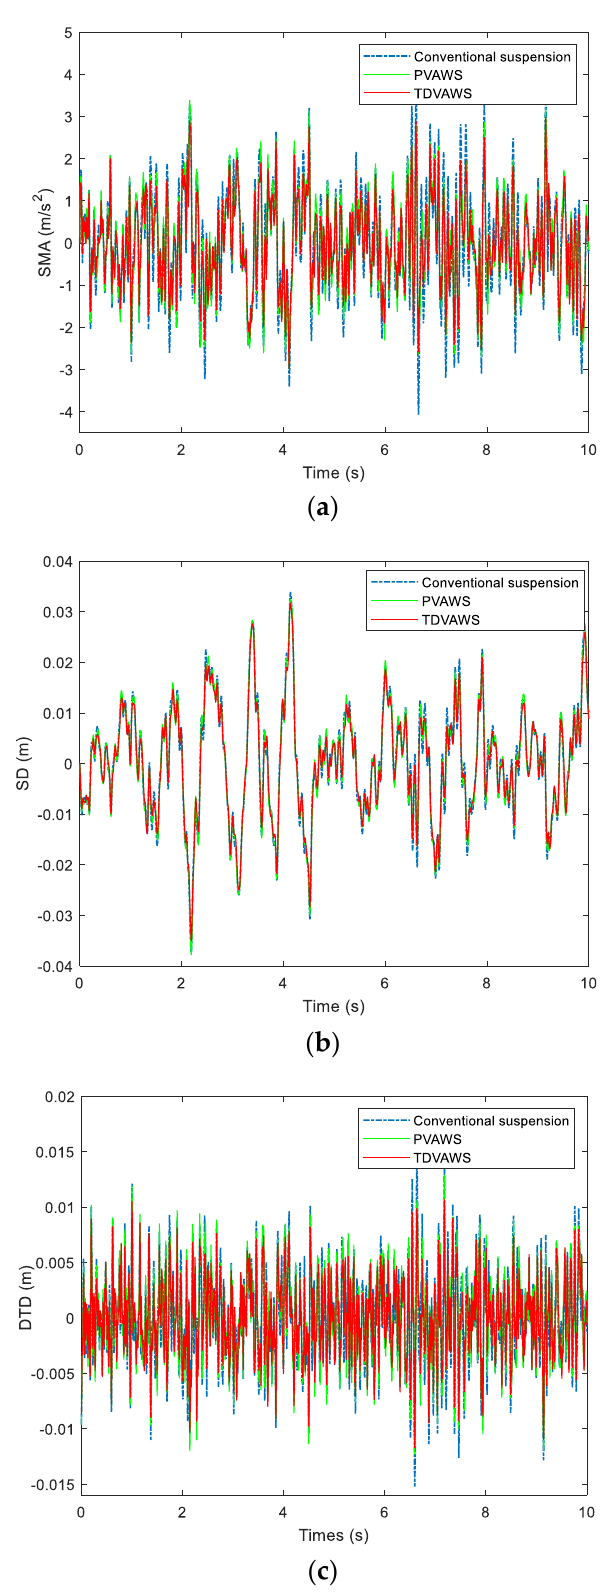
Figure 9. Simulation comparison under the road excitation. ( a ) sprung mass acceleration comparison chart; ( b ) suspension deflection comparison chart; ( c ) dynamic tire deflection comparison chart.